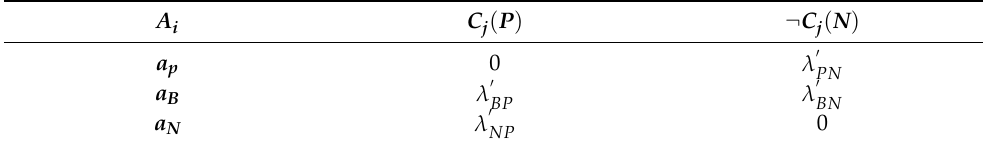
Table 2. Relative loss